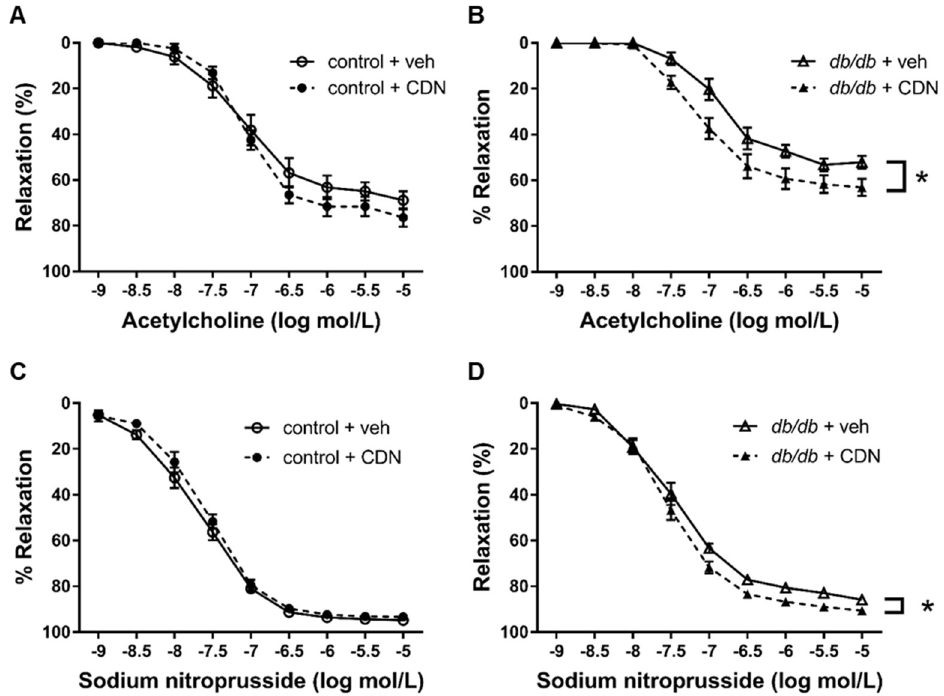
Figure 6. CDN1163 increases endothelium-dependent and endothelium-independent relaxation of db/db mice in in vivo experiments. ( A , B ) Vascular relaxation of aortic rings isolated from control mice ( A ) (Ctrl+veh, n = 11; Ctrl+CDN, n = 9) or db/db mice ( B ) (Db+veh, n = 10; Db+CDN, n = 11) with ACh. ( C , D ) Vascular relaxation of aortic rings isolated from control mice ( C ) (n = 9 for each group) or db/db mice ( D ) (n = 9 for each group) with SNP. Results of relaxation are expressed as percentage changes in the steady-state level of contraction with 10 −6.5 mol/L L-phenylephrine. Error bars represent SEM. * p < 0.05 vs. Db+veh. CDN, CDN1163; Ctrl, control mice; Db, db/db mice; veh, vehicle; SNP, sodium nitroprusside.